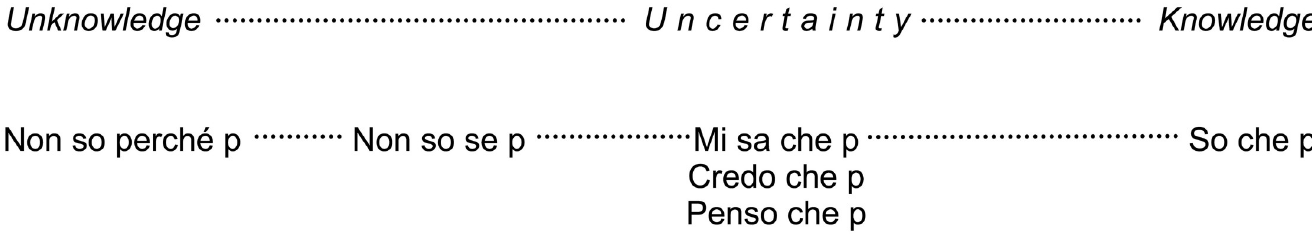
Fig 11. The six sentences along the epistemic continuum according to the results of Study